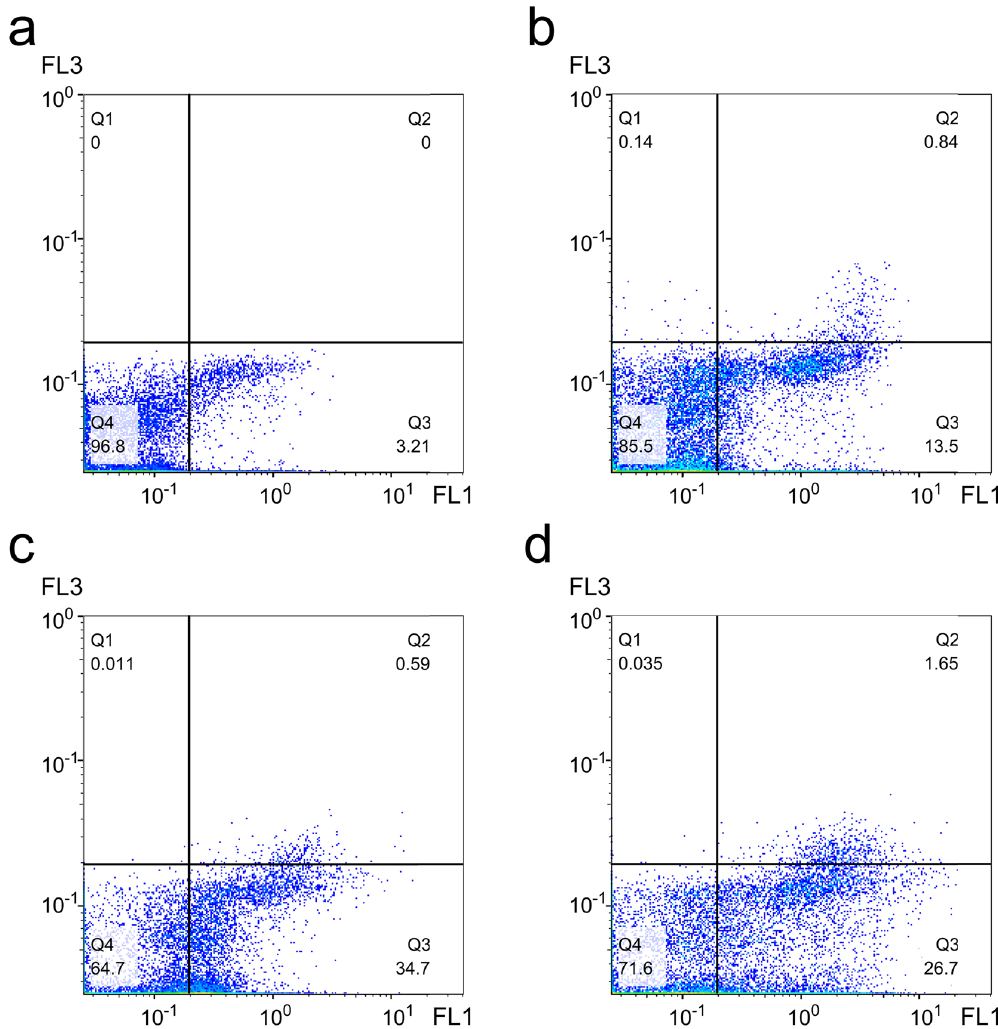
Figure 6. AnnexinV-FITC/PI analysis by flow cytometry in ( a ) control cells and ( b ) treated cells with OEO (1/2 IC 50 ) for 24 h ( c ) Treated cells with OEO (IC 50 ) for 24 h ( d ) Treated cells with Etoposide (positive control) (IC 50 ) for 24 h. Alive cells are Annexin V-FITC and PI negative; cells in early apoptosis are Annexin V-FITC positive and PI negative (lower right quadrant), and cells in late apoptosis or necrosis are both Annexin V-FITC and PI-positive (upper right quadrant).